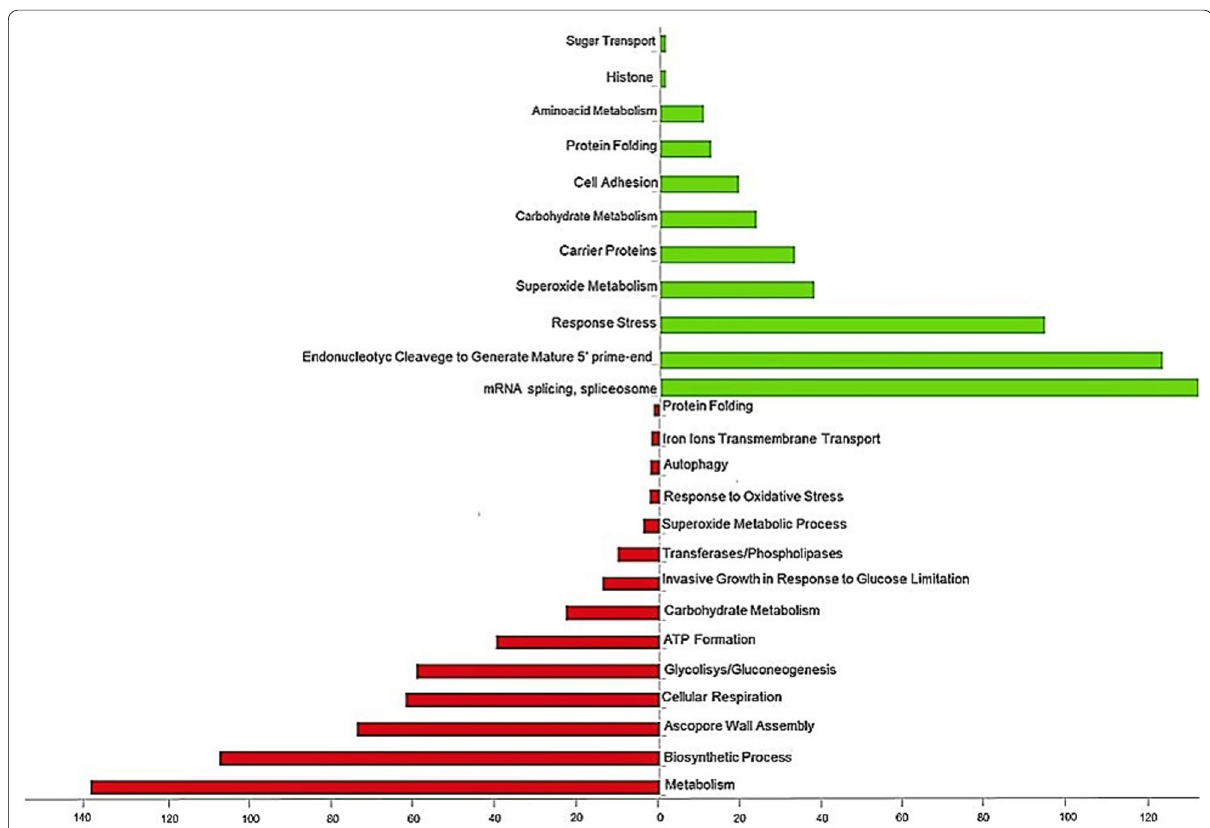
Fig. 2 Biological process quantification for up‑regulated and down‑regulated genes of contaminant yeast, C. tropicalis at 0 h and 8 h in the fermentation alcoholic cycle. a Biological process represent among down‑regulated genes at time 8 h (C8 and P8), represent per the bars in red color in contrast at time 0 h (C0 and P0); b biological process represent among up‑regulated genes at time 8 h (C8 and P8), represent per the bars in green color in contrast at time 0 h (C0 and